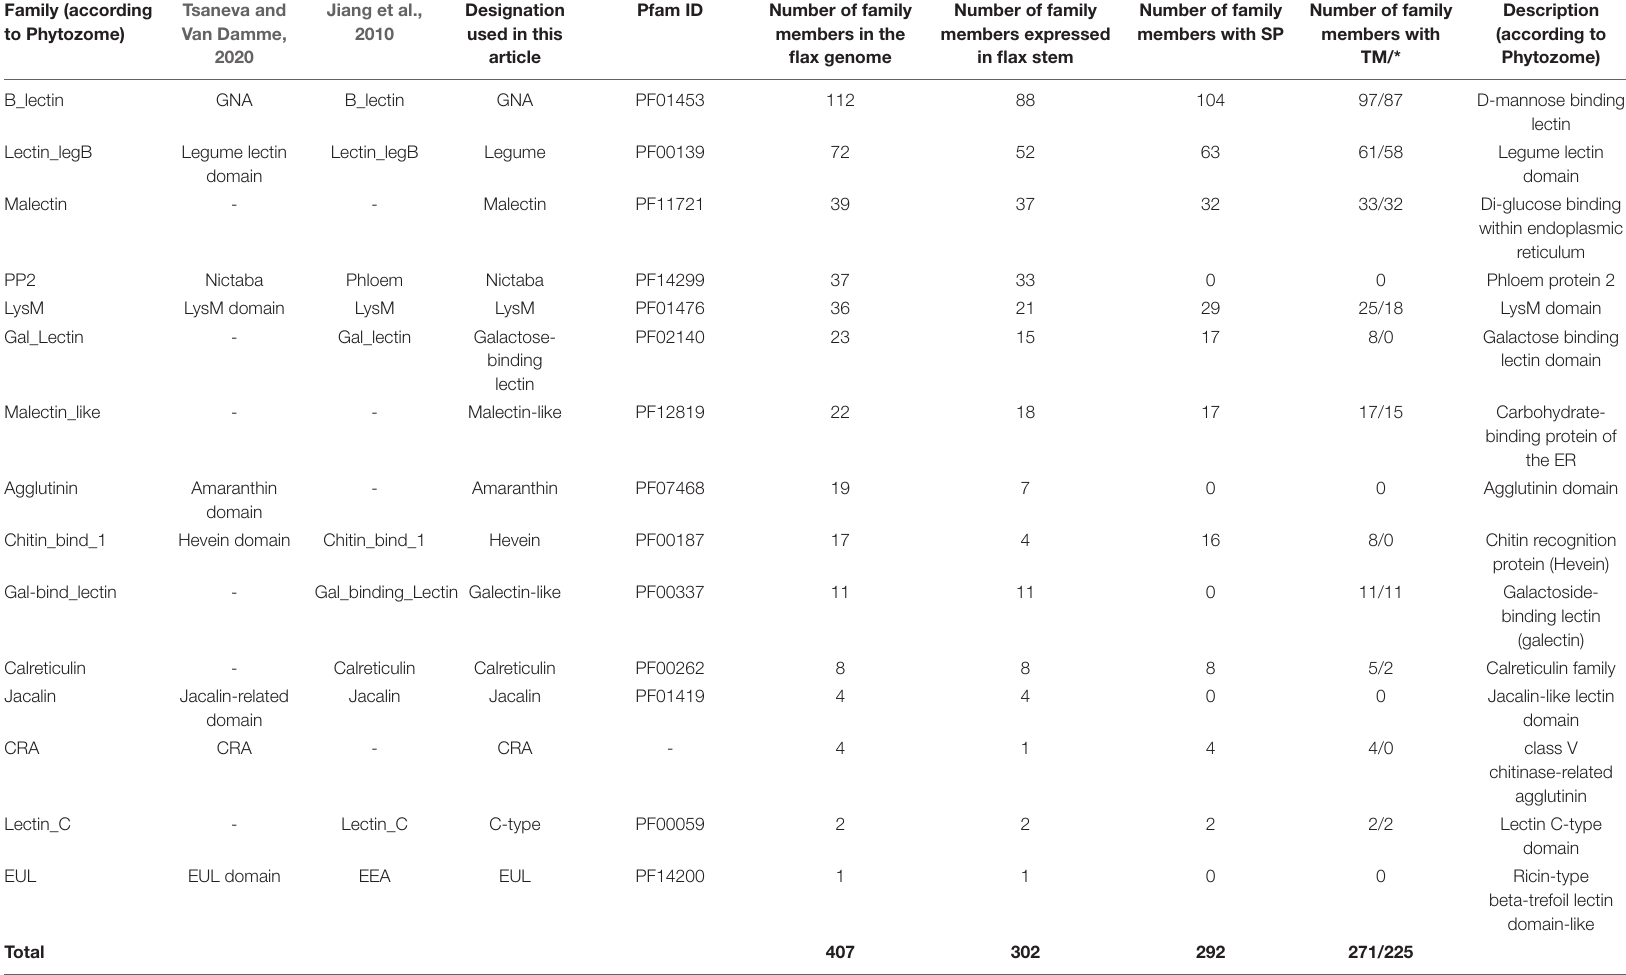
TABLE 1 | Distribution of proteins with lectin domains in the flax genome by families. Family (according to